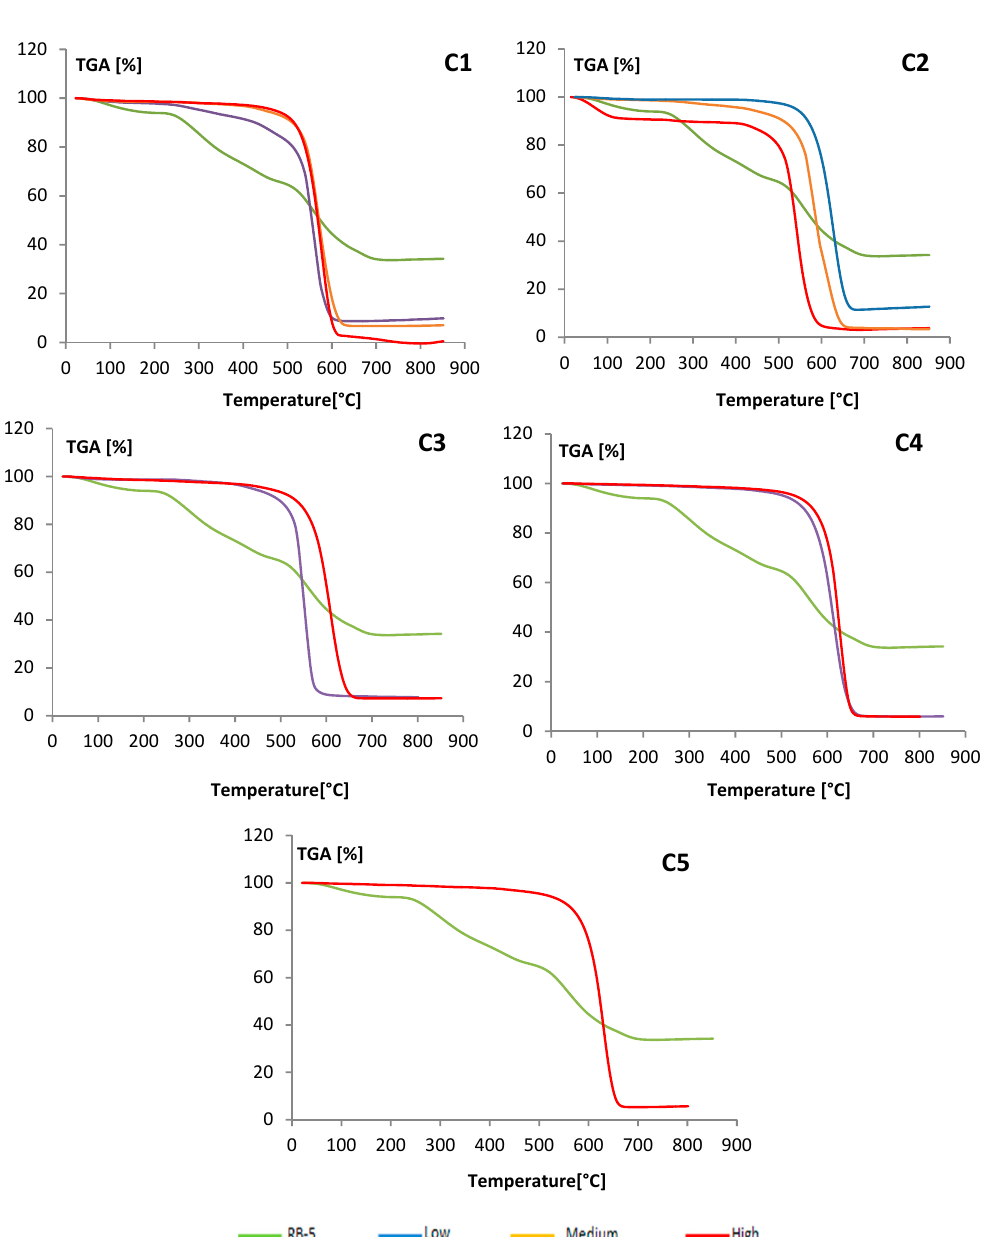
Figure 7. Samples taken in the different layers of MWCNTs. A comparison between the different TG curves of samples was possible. A TG curve of the pure RB5 dye is presented in Figure 8.